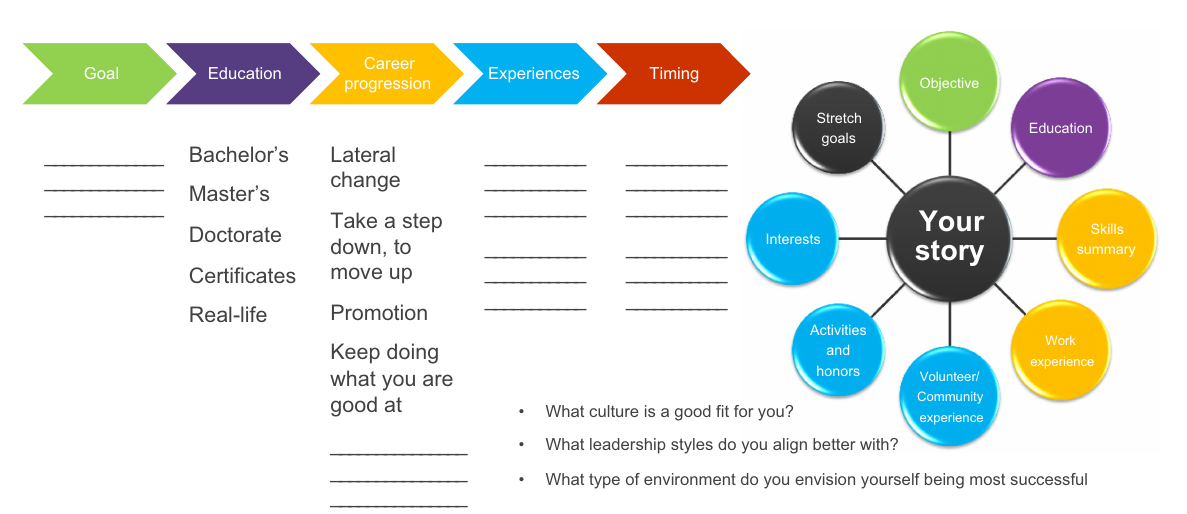
FIGURE 4 The use of a career transition strategy framework can provide you with a well-thought-through plan that lays out what is most important starting with the goals and desired outcome, working through the plan on how to best achieve. It also helps you to understand the non-negotiables. The non-negotiables become important when stress and anxiety increase, and confidence is in question. It also helps to keep you deeply grounded in your purpose. Personal Brand